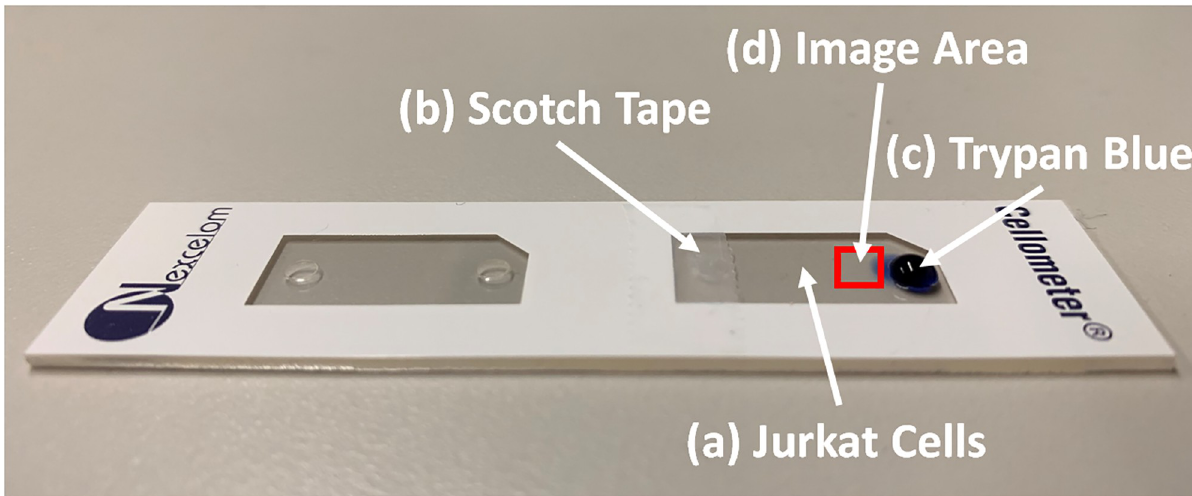
Fig 1. Counting chamber setup for video acquisition. (a) A Nexcelom counting chamber is first filled with 20 μ L of Jurkat cells. (b) A small piece of Scotch tape is then placed over the air escape hole to inhibit flow of liquid in the chamber. (c) Next, a 10 μ L aliquot of trypan blue is pipetted into the inlet hole to allow diffusion into the chamber. (d) The red square indicates the location were the interaction between Jurkat cells and trypan blue is